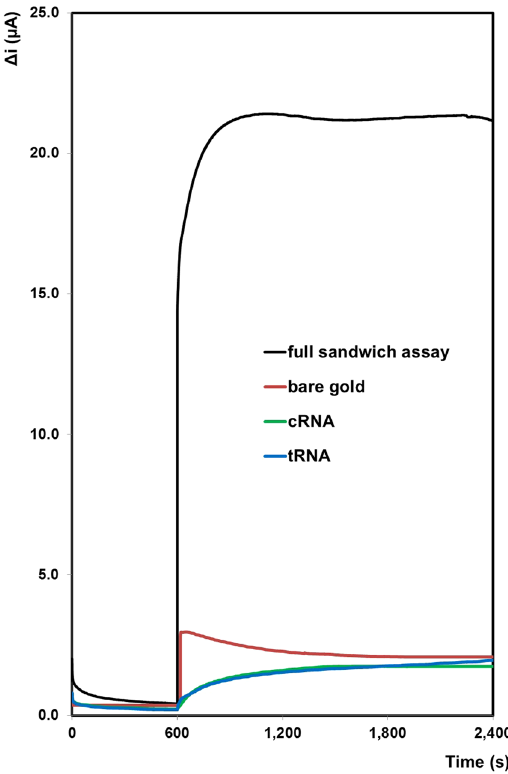
Figure 4. Amperometric i-t curves for a bare gold electrode (red line), a gold electrode functionalised with 1 µ M capture miRNA (cRNA, green line), a gold electrode functionalised with 1 µ M capture miRNA and hybridised to 1 µ M target miRNA (tRNA, blue line), and a gold electrode functionalised with capture, 1 nM target and probe miRNA labelled with platinum nanoparticles (full sandwich assay, black line). Potential applied is − 0.25 V in 1 mM DPBS. The difference in current before and after the addition of 20 µ M H 2 O 2 is